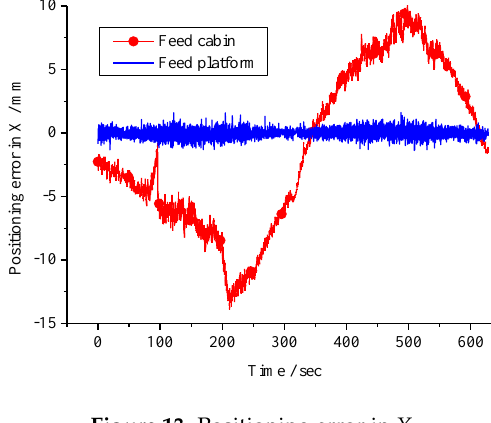
Figure 13 . Positioning error in X. Figure 13. Positioning error in X .